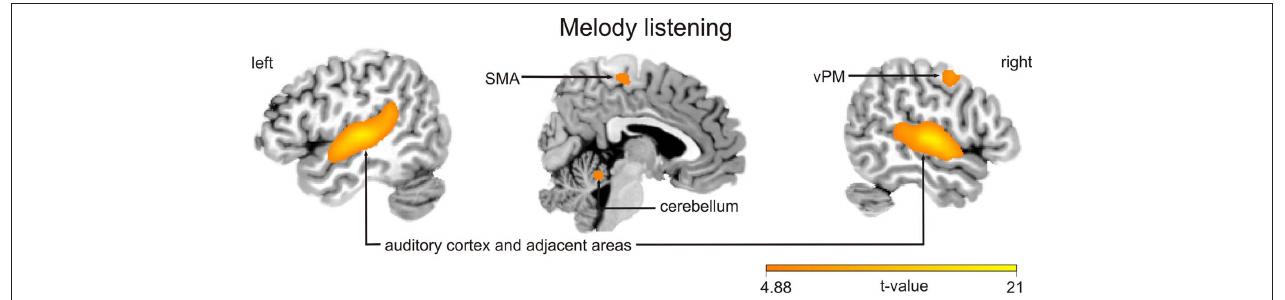
FIguRe 2 | Blood oxygen level dependent activation patterns of the (AnD) conjunction analyses of all four listening conditions (i.e., listening to improvised and imitated melodies judged to be either improvised or imitated, each contrasted against rest). The statistical parametric map (SPM) is superimposed on an MNI standard brain and thresholded at P < 0.05, FWE corrected. The color bar indicates t statistic values. vPM, ventral premotor area; SMA, supplementary motor